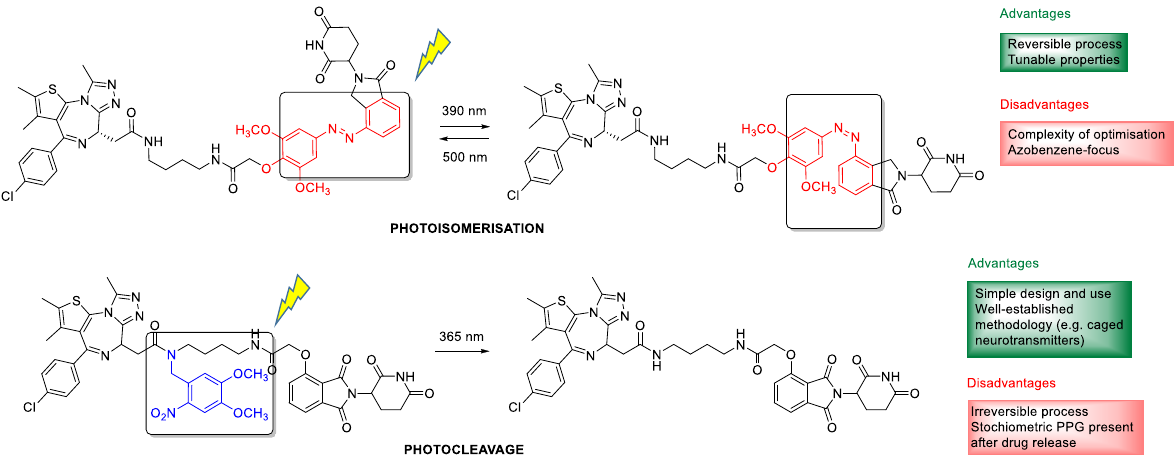
Figure 1. Photocaged vs. photoswitchable pharmacological agents, with the respective photoactivated transformations.